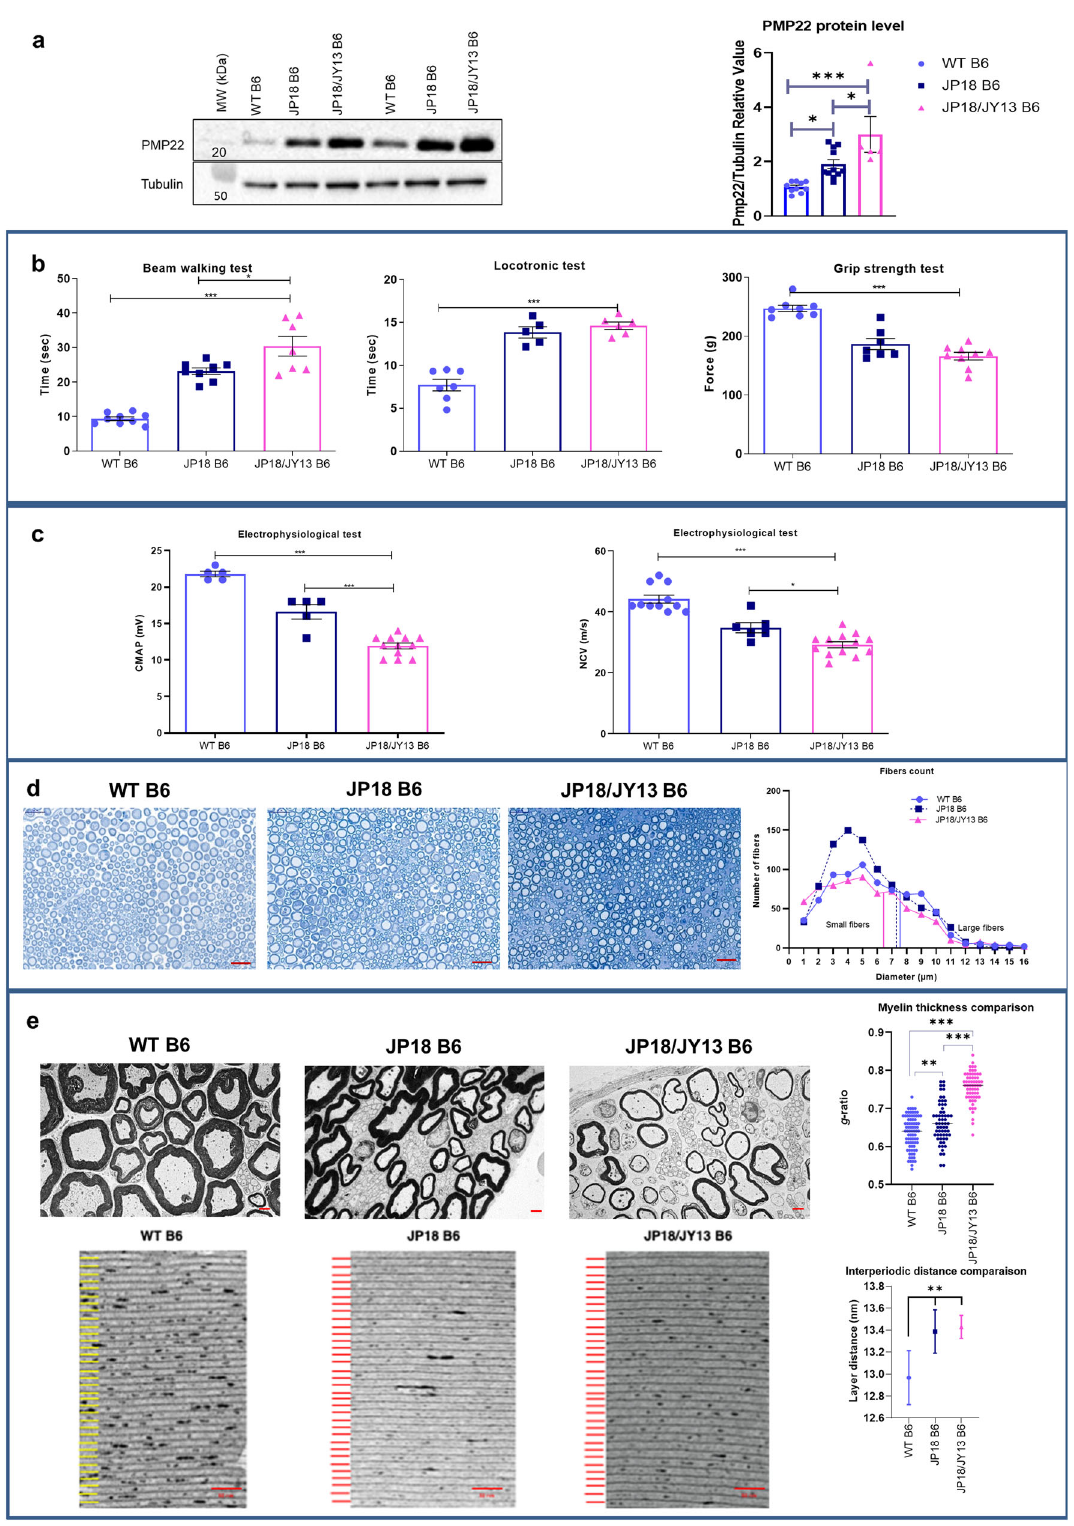
and KROX20 (EGR2), both implicated in Schwann cell develop- ment and myelination 39 . Indeed, the PMP22 gene harbors an intron site that is strongly activated by SOX10 and KROX20 and involved in the regulation of PMP22 expression 40 . A signi fi cant decrease in the levels of the transcription factors was observed in both transgenic mouse models when compared to WT mice ( p < 0.001 for SOX10 and KROX20 in JP18 mice; p < 0.001 for